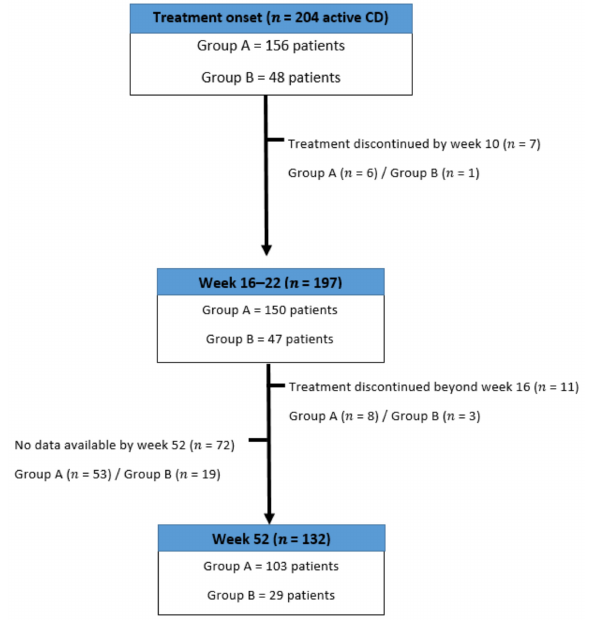
Figure 1. Chart of the patients’ flow during the study period. CD, Crohn’s disease; group A, patients received vedolizumab (VZD) as a second-class therapy and ustekinumab (UST) as a third-class therapy; group B, patients received UST as a second-class therapy and VDZ as a third-class therapy.